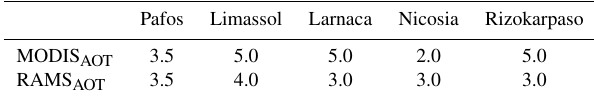
Table 2. Maximum MODIS and RAMS AOT over Cyprus (8 September 2015).